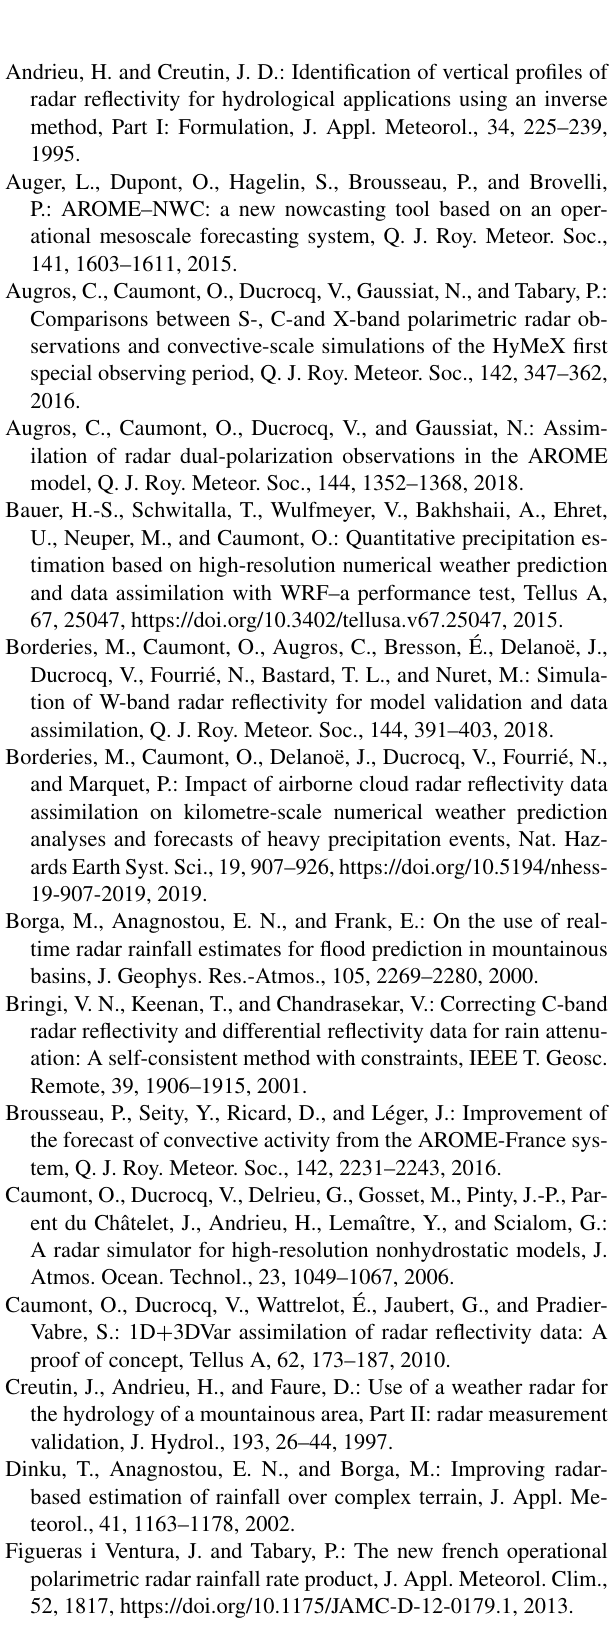
Figueras i Ventura, J. and Tabary, P.: The new french